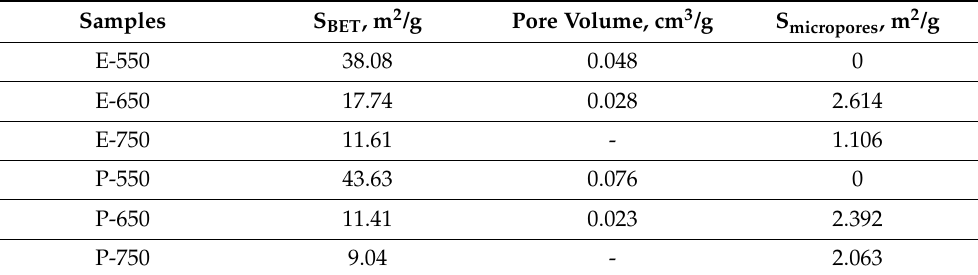
Table 4. Textural properties of the samples calculated from the nitrogen adsorption isotherms